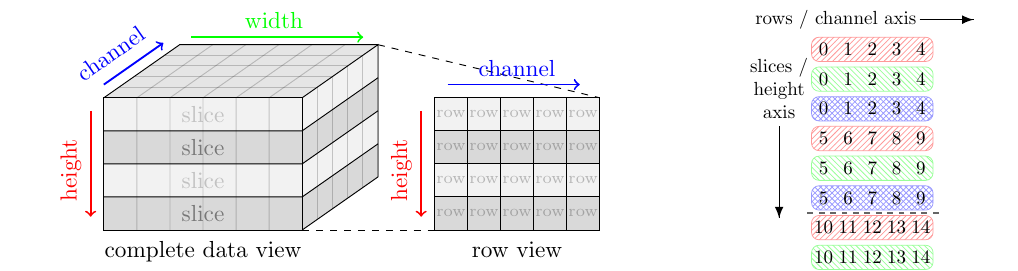
Figure 2. The Illustration on the left shows how ’slices’ and ’rows’ are related to the original data volume. A slice contains all elements at a given height, a row spans the entire width at a given height and channel position. The schematic on the right shows an example of the row unit allocation scheme. Positions marked with a 0 are computed first, all others require the indicated number of delay cycles. The di ff erent colors (patterns) indicate which row unit covers a given row.